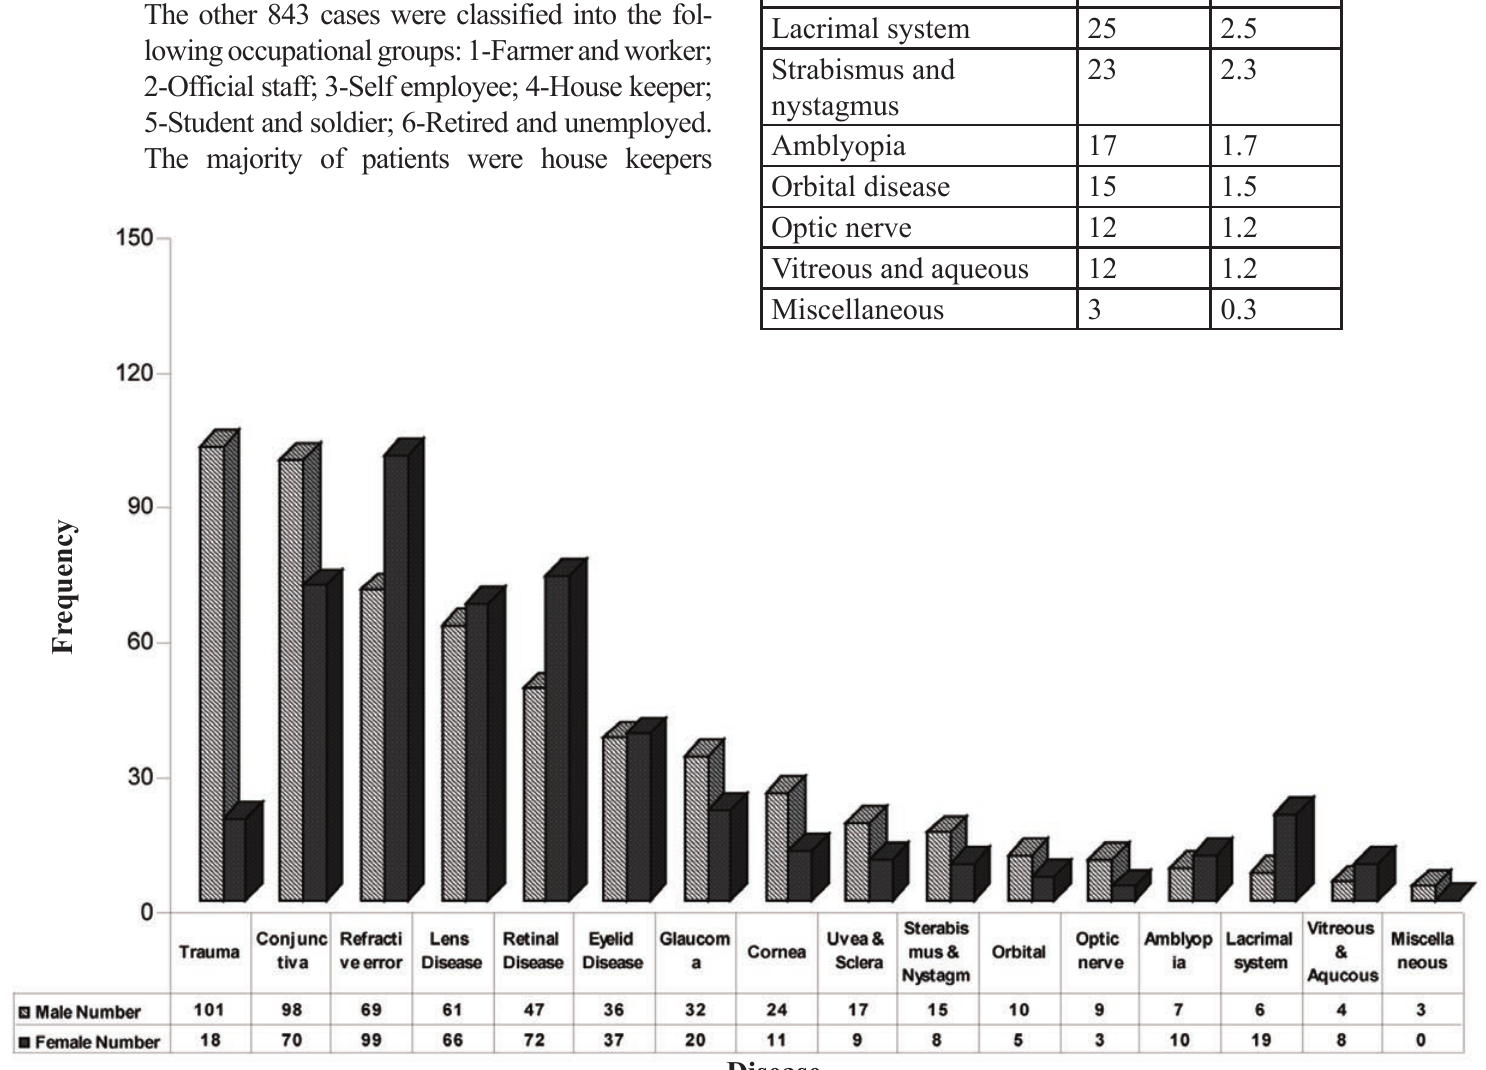
Figure 2 . The ocular disease frequency based on the sex.